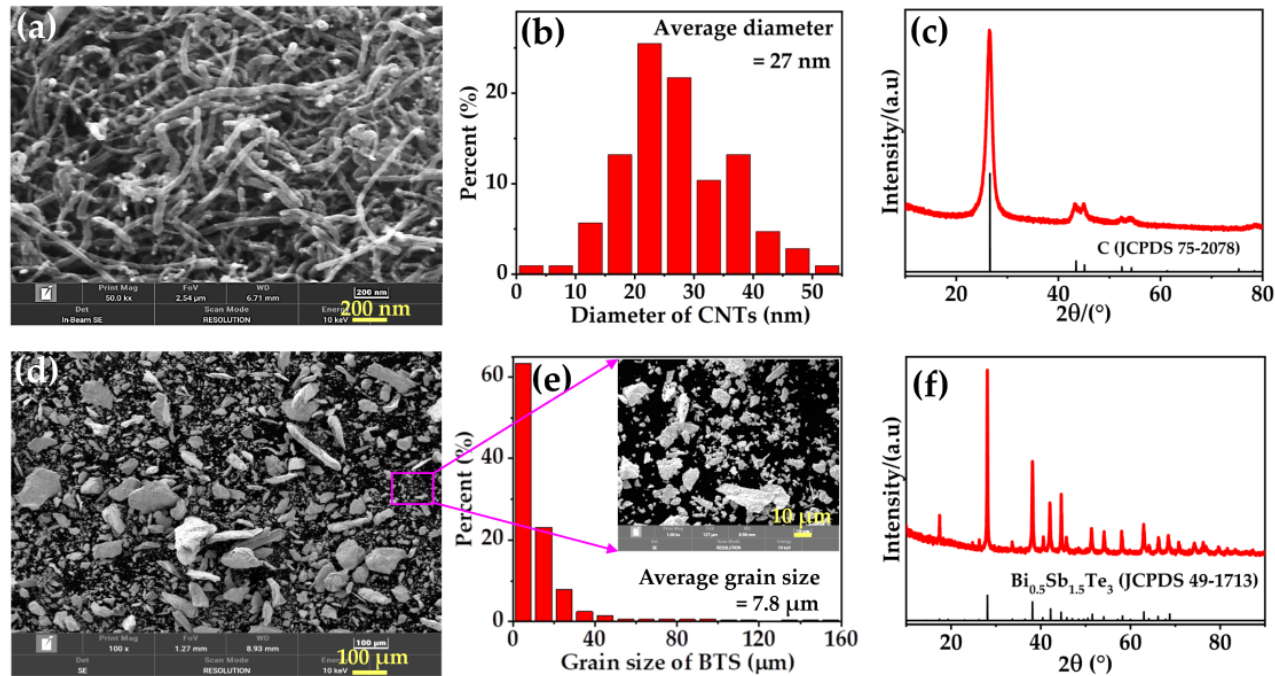
Figure 2. SEM images of ( a ) CNTs and ( d ) as ‐ prepared Bi 0.5 Sb 1.5 Te 3 powders. The corresponding size distributions, which were statistically analyzed from SEM images of ( a , d ), are shown along with ( b , e ), respectively. XRD pattern of them are also shown in ( c ) CNTs, and ( f ) as ‐ prepared Bi 0.5 Sb 1.5 Te 3 powders. The inset in ( e ) is the enlarged SEM image of ( d ).